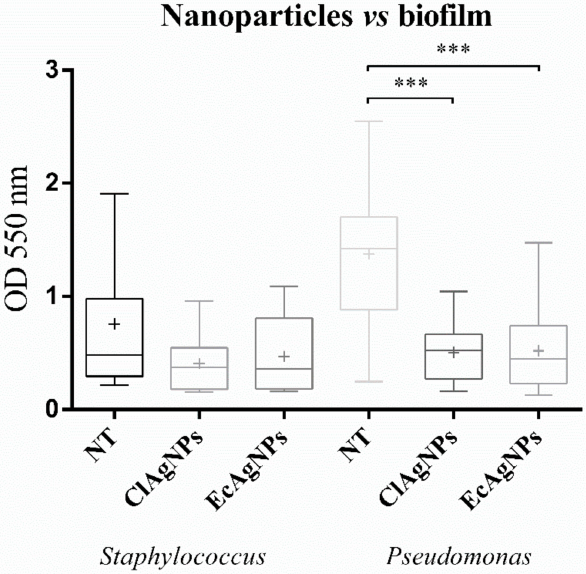
Figure 6. Anti-biofilm properties of NPs. Statistical di ff erences were found only among Pseudomonas strains (*** p -value: <